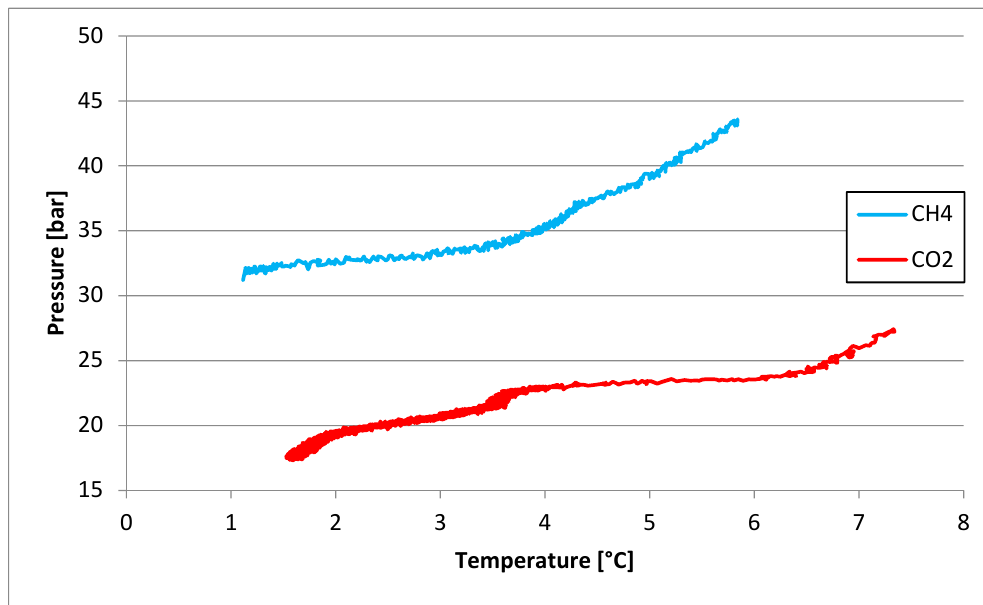
Figure 1. Comparison between P–T diagrams of hydrate formation carried out with methane (in blue) and carbon dioxide (in red).